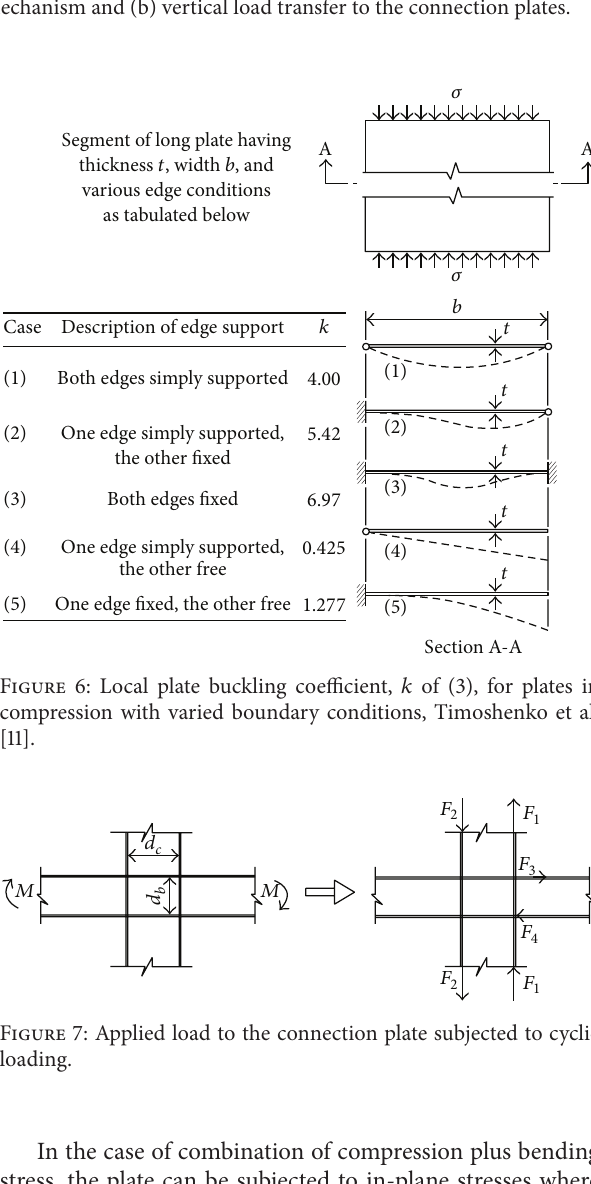
Figure 4: Load transfer path of saddlebag connection: (a) yielding mechanism and (b) vertical load transfer to the connection plates.